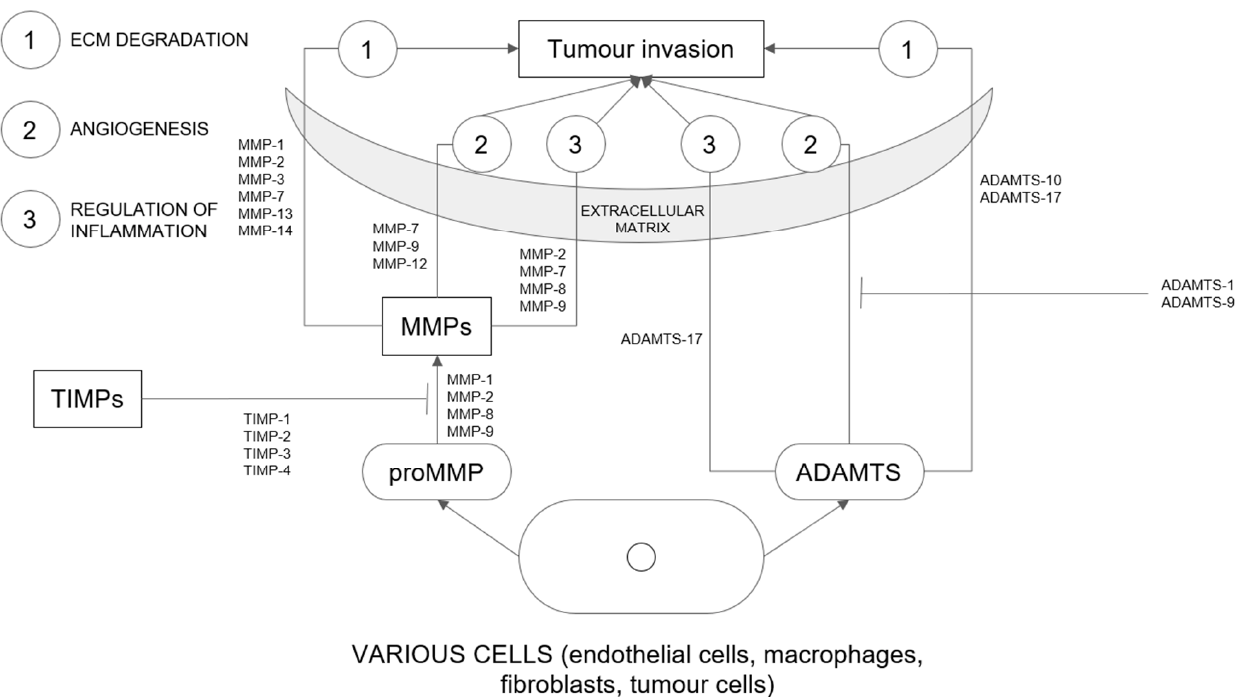
Figure 2. Main mechanisms of action of metalloproteinases, ADAMTSs and TIMPs in extracellular matrix. Abbreviations: ECM, extracellular matrix; MMP, metalloproteinase; TIMP, The tissue inhibitors of metalloproteinases; ADAMTS, A disintegrin and metalloproteinase with thrombospondin motifs.